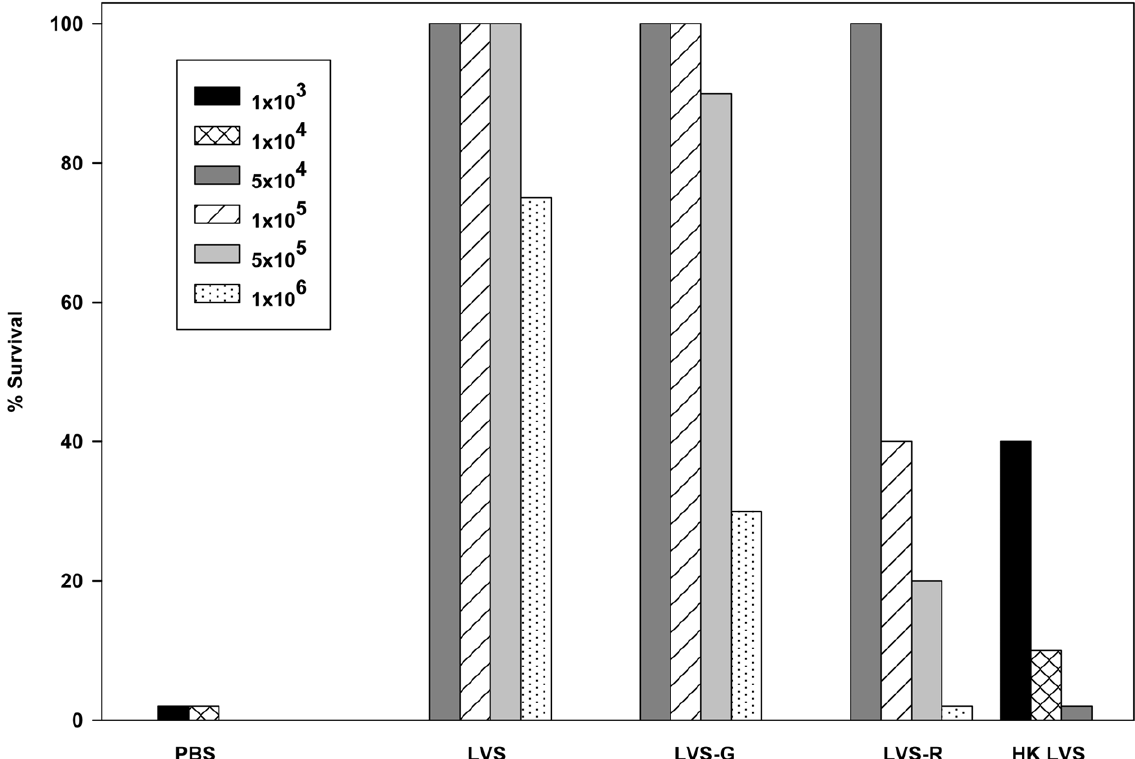
Figure 1. Hierarchy of strength of protection against lethal systemic F.tularensis LVS challenge after vaccination of mice with LVS or the variants LVS-G, LVS-R, and heat-killed LVS. C57BL/6J mice were immunized by ID infection with 1 6 10 4 CFU LVS, 1 6 10 8 HK-LVS, 1 6 10 4 LVS-G, or 1 6 10 4 LVS-R. At 6 weeks after vaccination, mice vaccinated with PBS were challenged with 10 3 or 10 4 LVS IP; mice vaccinated with HK-LVS were challenged with 10 3 , 10 4 , or10 5 LVS IP; and mice vaccinated with LVS, LVS-G, and LVS-R were challenged with 5 6 10 4 , 10 5 , 5 6 10 5 , or 10 6 LVS IP, as indicated for each group, and monitored for survival. Results shown are from one representative experiment of three independent experiments of similar design with similar outcome.